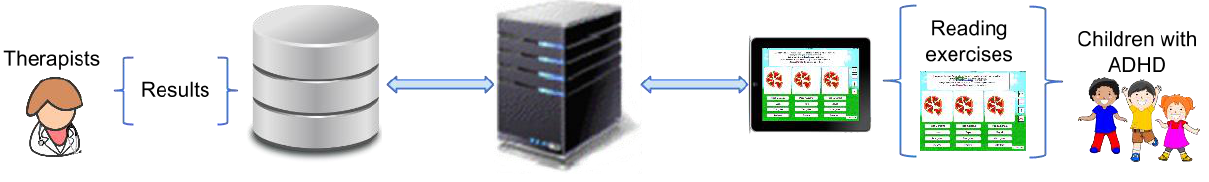
Figure 3. General outline of interaction in the system.